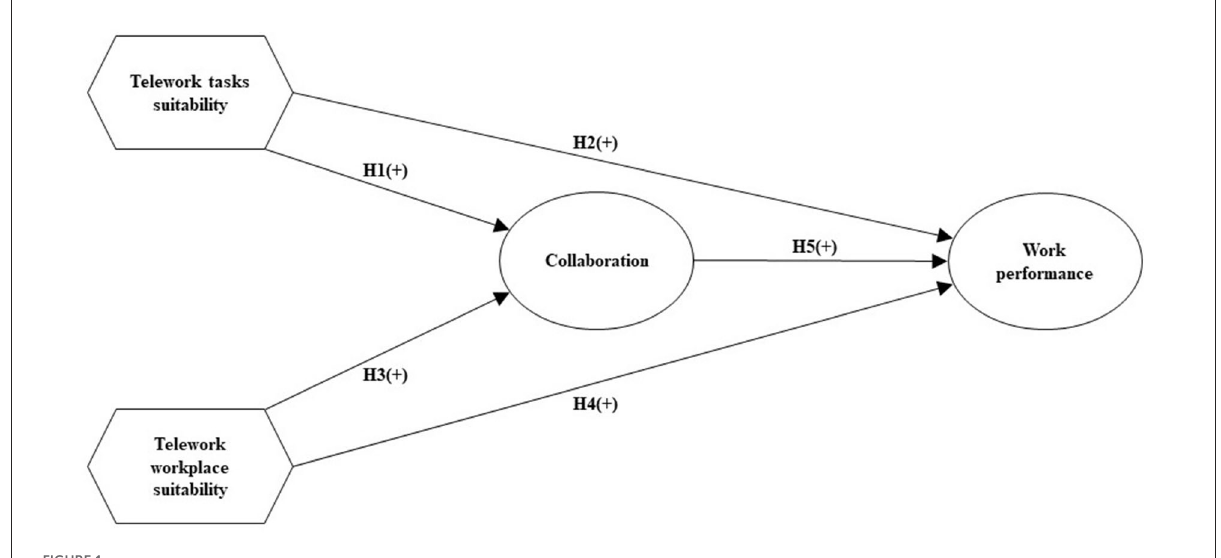
FIGURE1 Conceptual